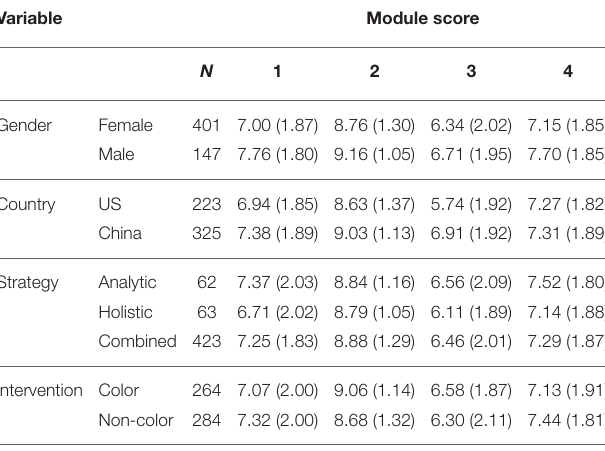
TABLE 3 | Descriptive statistics for 548 participants (response scores).